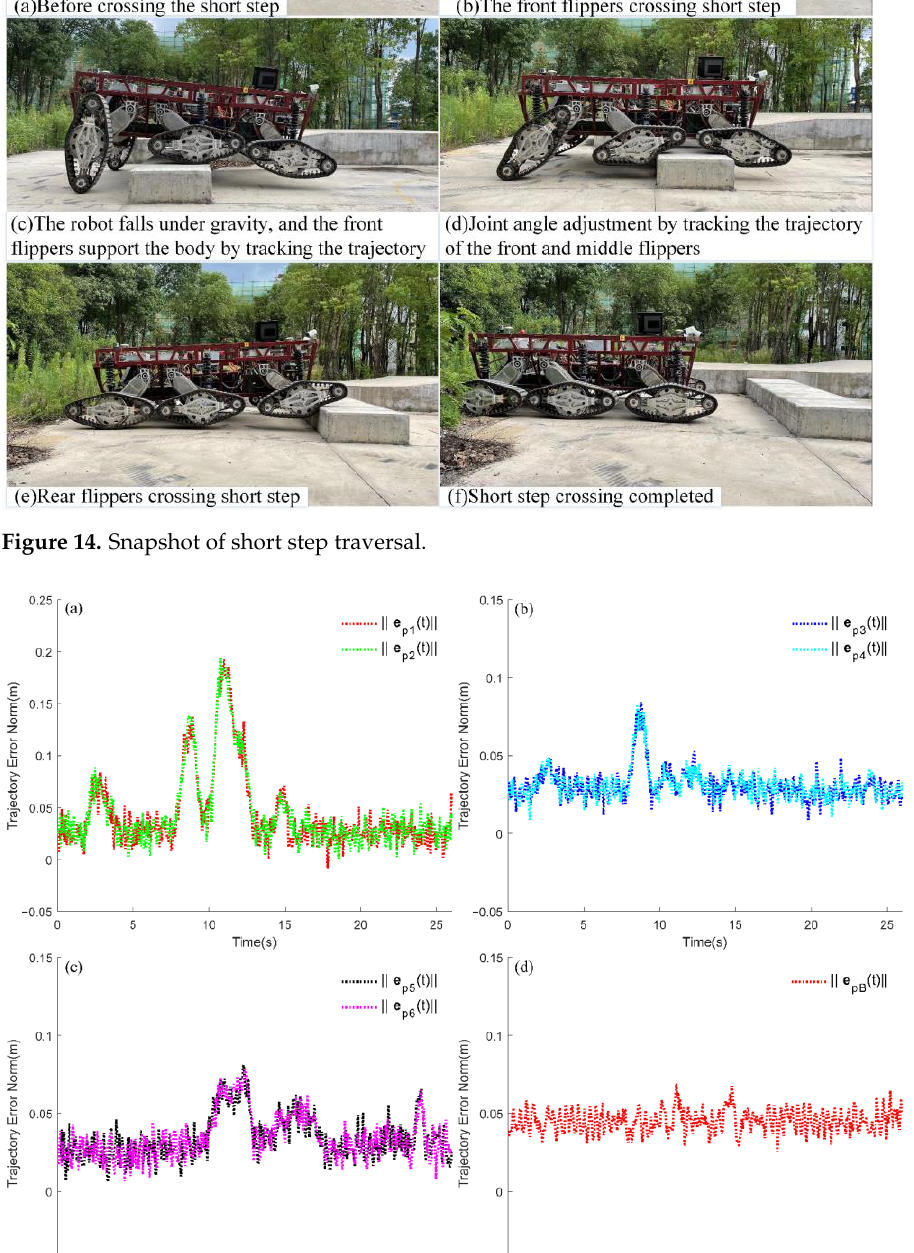
Figure 16. Snapshot of the autonomous controller traversing the slope terrain. Table 3 shows the performance comparison results of the three controllers: (1) the mean error norm of the center of mass 𝐞 𝐵 (𝑡) , (2) the obstacle traversal time 𝑡 , (3) the slip- ping norm Δ𝜎 , and (4) the maximum response, including the maximum linear and angu- lar velocities. The wide body of the six-track robot complicates its turn maneuver, espe- cially in the turning and obstacle traversal phases. In addition, the inclined path in the circular experimental fields increases the adjustment process. The autonomous obstacle traversal controller considers the slip effect between the track and the terrain, while it can follow the trajectory with high precision, reducing the average error norm by 40.7% and 13.5%, while the maximum slip norm is reduced by 34.6% and 19.9% compared to manual remote control and prior art controller, respectively. Furthermore, the planned path re- quires the six-track robot to move at high speed on wheels on flat terrain, while the syn- chronous convergence of flipper tracking error and mass center tracking error reduces the influence of traction speed on the obstacle traversal, thus limiting obstacle traversal time by 21.3% and 9.3%, respectively. The performance of the autonomous obstacle traversal